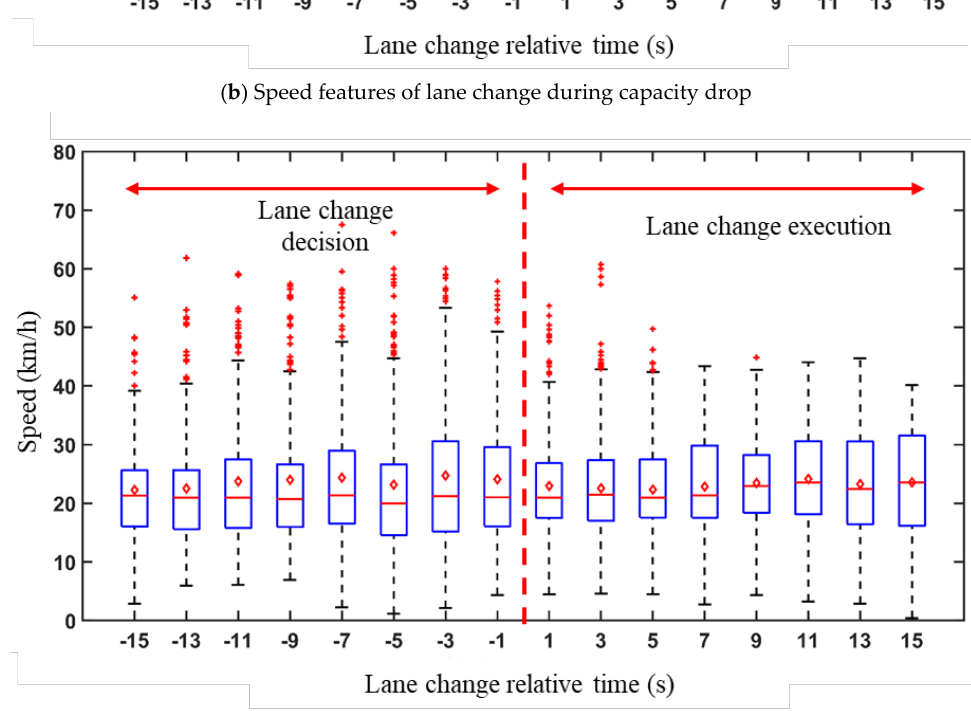
Figure 5. Speed features of lane change vehicles.